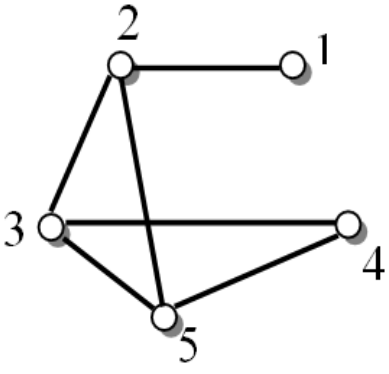
Figure 7. Graph G a in a numerical example of Section 4. G Figure 7. Graph in a numerical example of Section IV. a